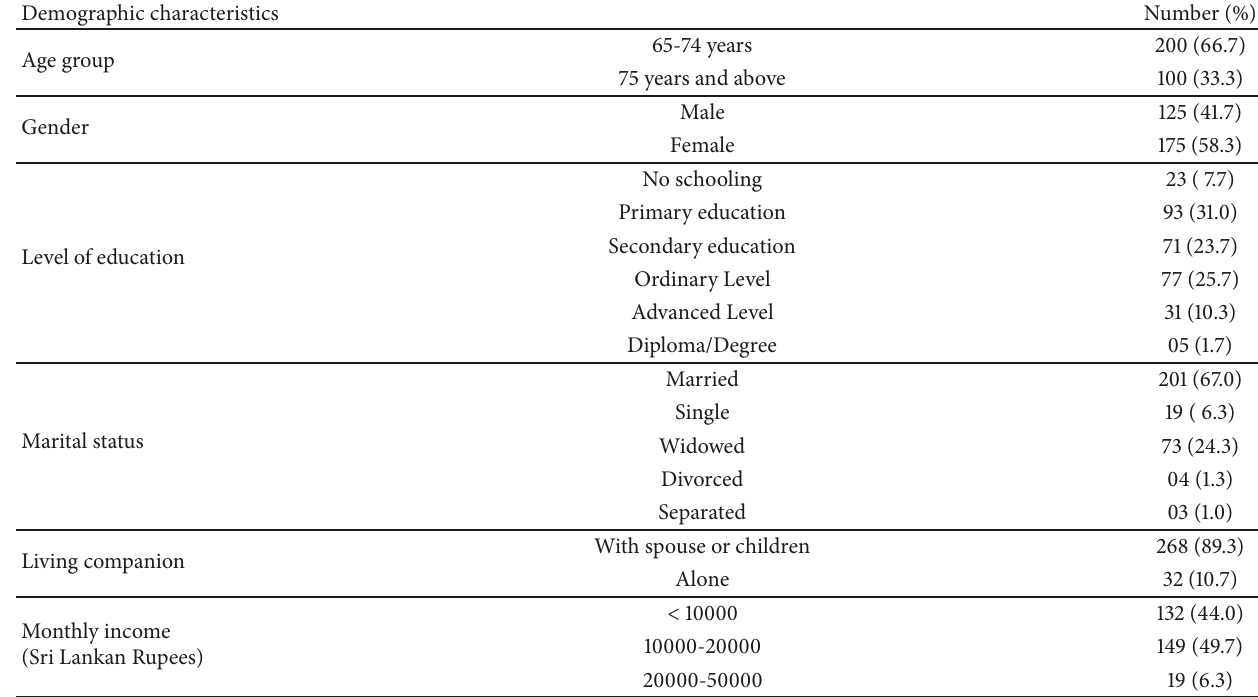
Table 1: Demographic characteristics of the study sample (n=300).